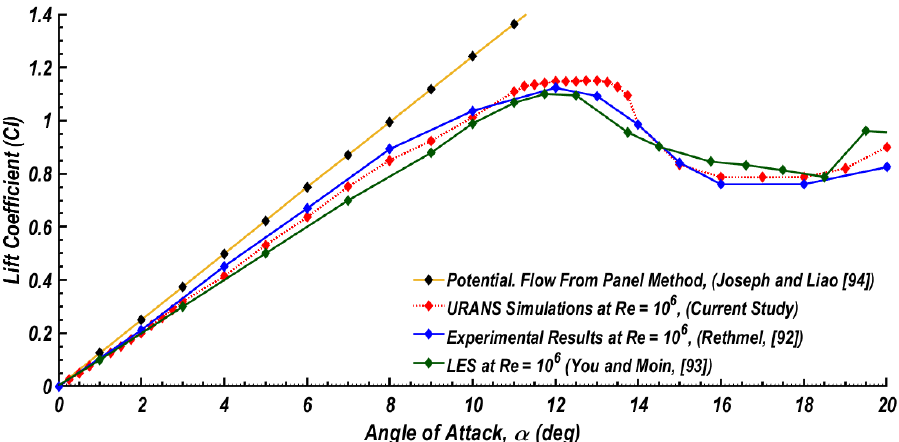
Figure 4. Airfoil average lift coefficient as a function of angle of attack at chord Re = 10 6 (No-control case). The slope of the lift curve for the idealized potential flow case is predicted variation of average drag coefficients with the angle of attack and gives a comparison with